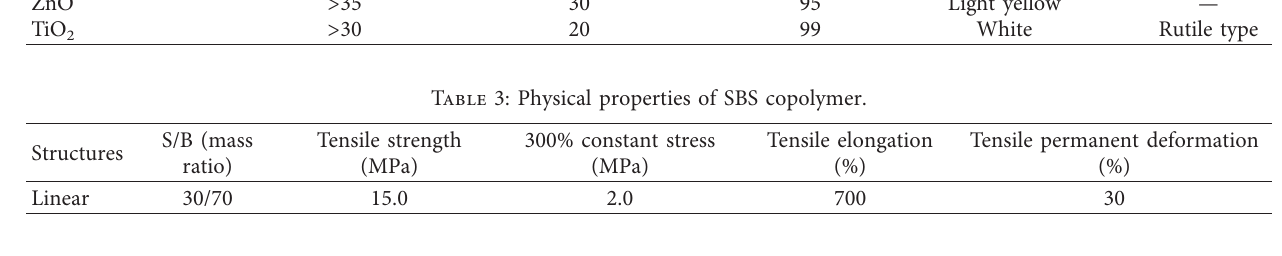
Table 4: Design of orthogonal experimental.